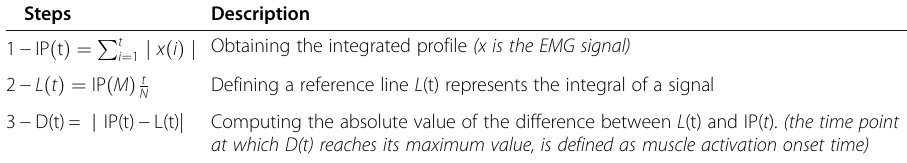
Table 2 The integrated profile method utilized for muscle activation onset detection [29] Steps Description